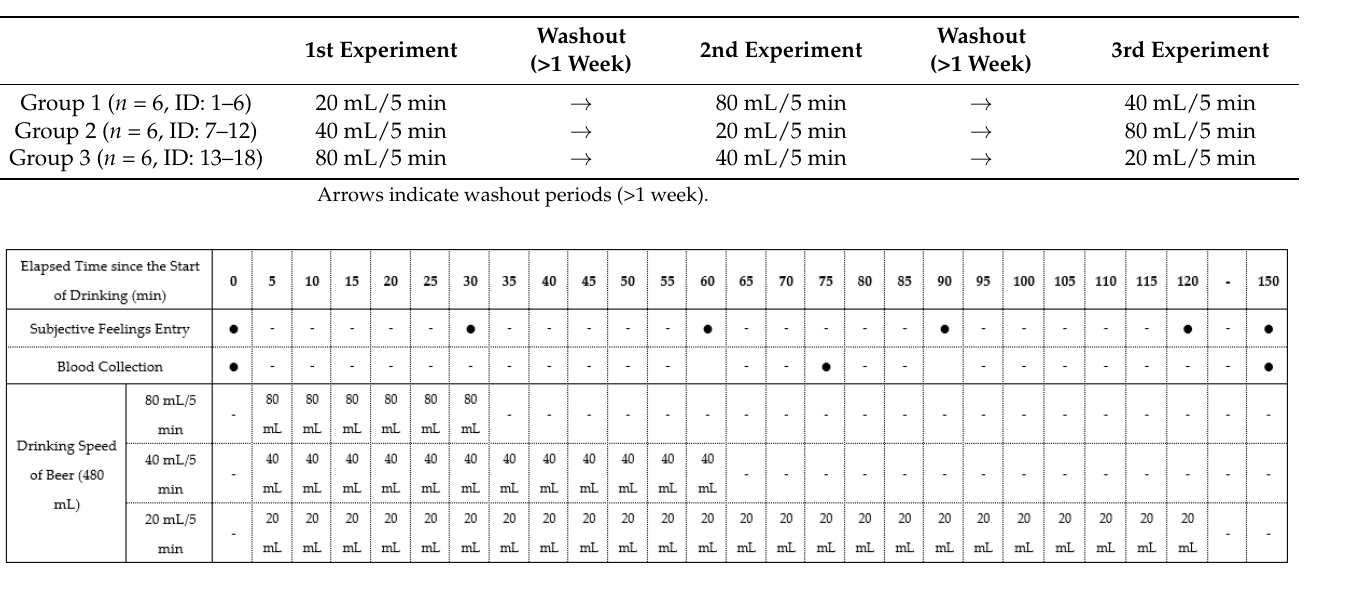
Figure 1. Time schedule of the experiments. Participants drank 480 mL of beer at three different speeds (80, 40, and 20 mL/5 min).